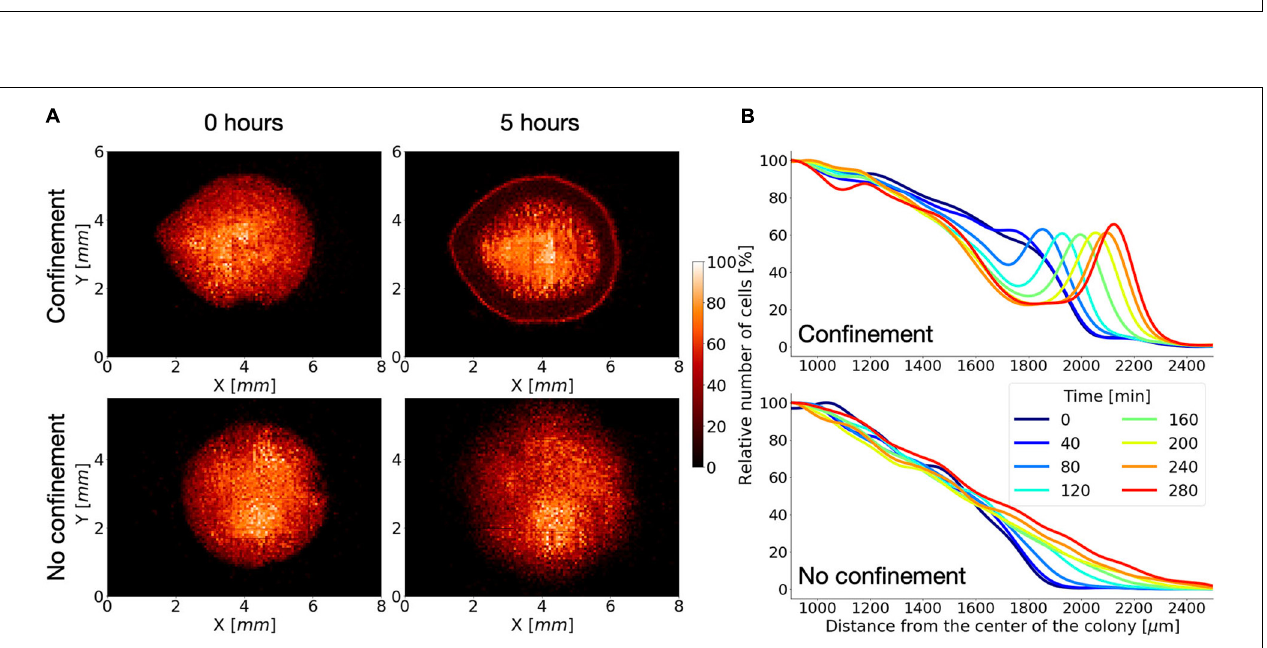
FIGURE 1 | Aerotactic migration of growing AX2 cells. (A) Time lapse images of live-cell migration toward a region of higher oxygen concentration (on the right of the image). Time (h) refers to the time that elapsed under confinement. (B) Magnification of the image after 5 h of confinement. Scale bar = 200 µ m. Asterisks indicate approximately the center of the cell cluster.